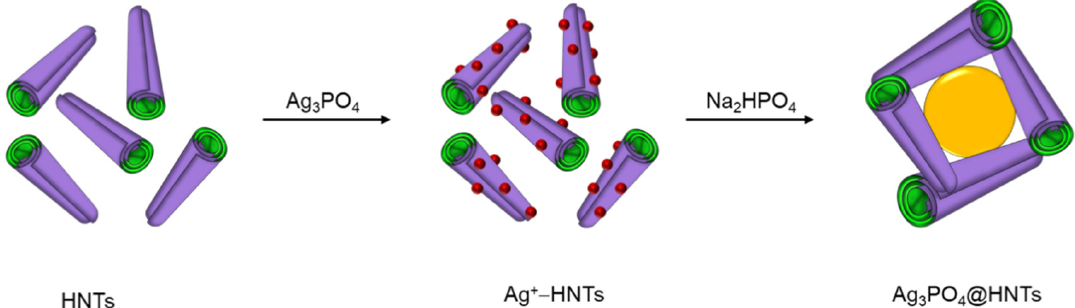
Figure 11. Schematic representation of the synthesis of core-shell structured Ag 3 PO 4 @HNTs nanomaterial. Adapted with permission from ref. [100]. Copyright 2017